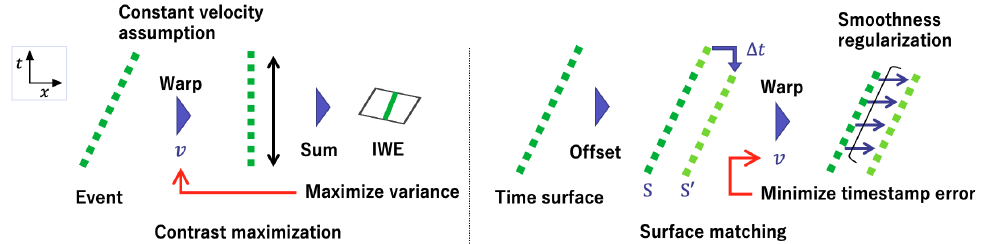
Figure 4. Comparison of the contrast maximization ( left ) and our surface matching approach ( right ). In the contrast maximization, alignment of events is implicitly measured by the contrast of the image of warped events (IWE) generated from warped events. In our surface-matching approach, alignment is evaluated by the timestamp consistency referring to the fixed previous time surface S . The green dots indicate the events in x − t